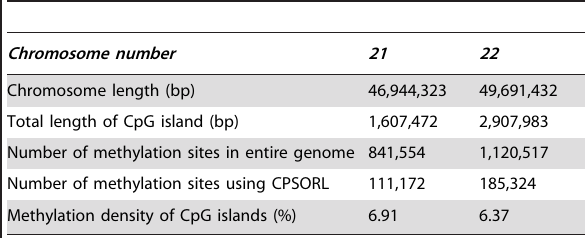
Table 4. Number of methylation sites identified with CPSORL in chromosomes 21 and 22 of the human genome. (NCBI. 36).